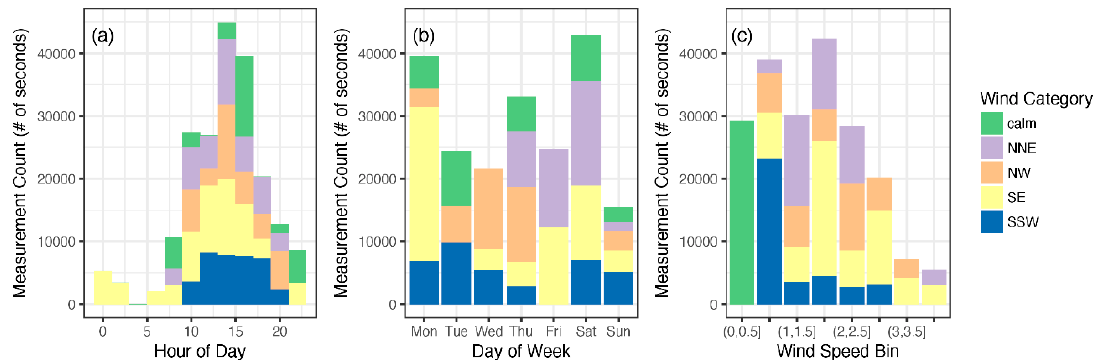
Figure 2. Measurement count by ( a ) time-of-day and wind category ( b ) day-of-week and wind category and ( c ) wind speed and wind category.